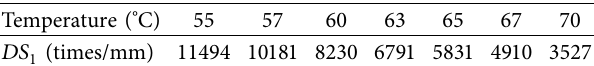
Table 4: Results of the APA